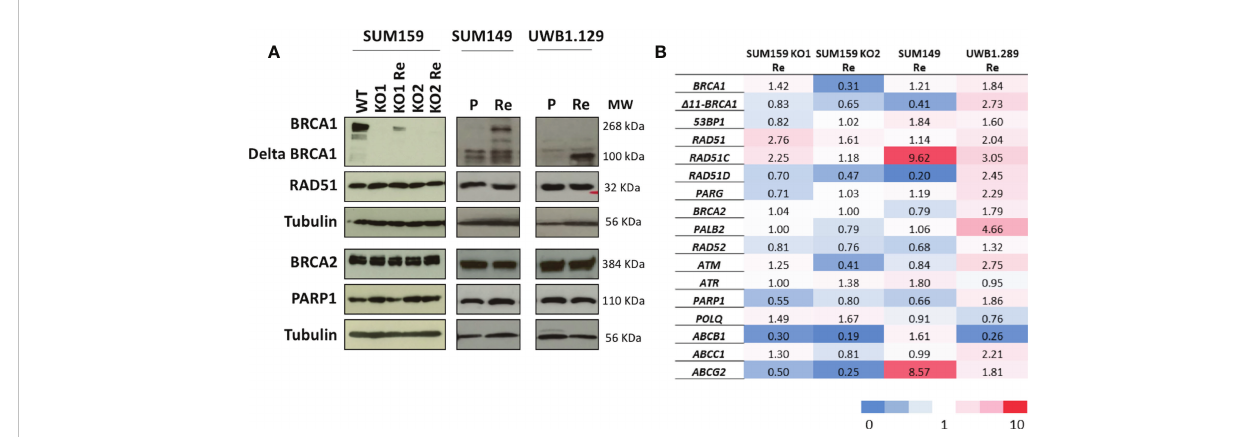
FIGURE 4 Protein and mRNA expression pro fi les of principal HR genes in the cell line models (A) Western blots showing protein expression patterns; analyzed proteins are indicated on the left and molecular weights in KDa on the right. (B) mRNA expression changes of genes potentially associated with olaparib resistance in cell line models selected for acquired olaparib resistance. mRNA levels are expressed as fold changes of the expression levels measured between the olaparib-resistant cell line and their parental lines used as reference (horizontal line). Reference cell lines were SUM159-KO1, SUM159-KO2 parental SUM149 and parental